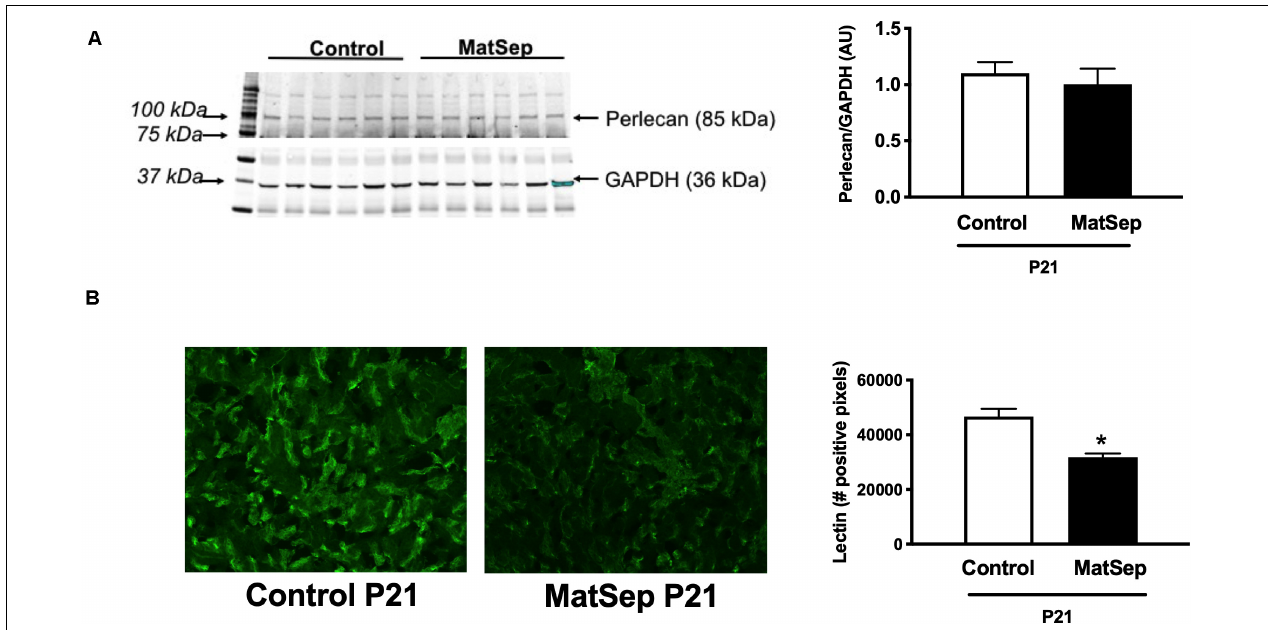
FIGURE 3 | Effect of maternal separation (MatSep) on: (A) renal protein expression of perlecan, and (B) immunostaining intensity for lectin in 3-week old male weanlings (P21). * p < 0.05 vs. C. n = 5 per